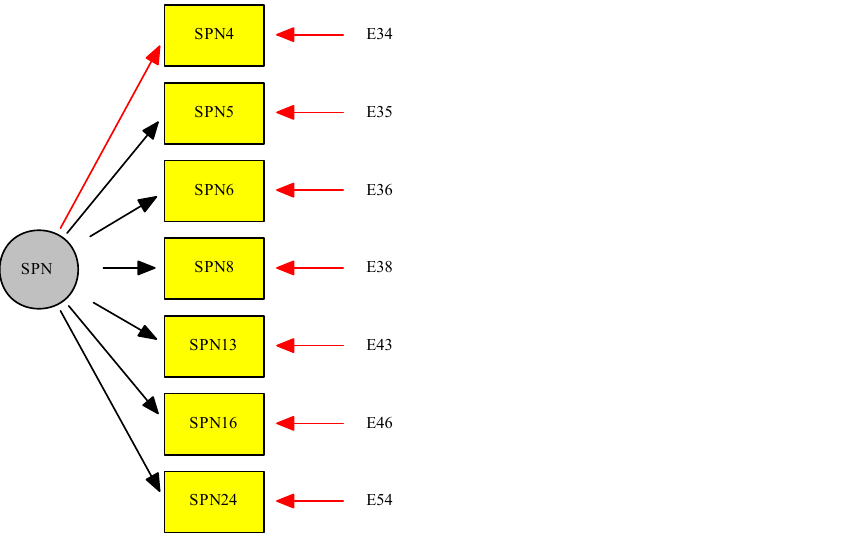
Figure 1. Measurement model of Stakeholders’ participation.